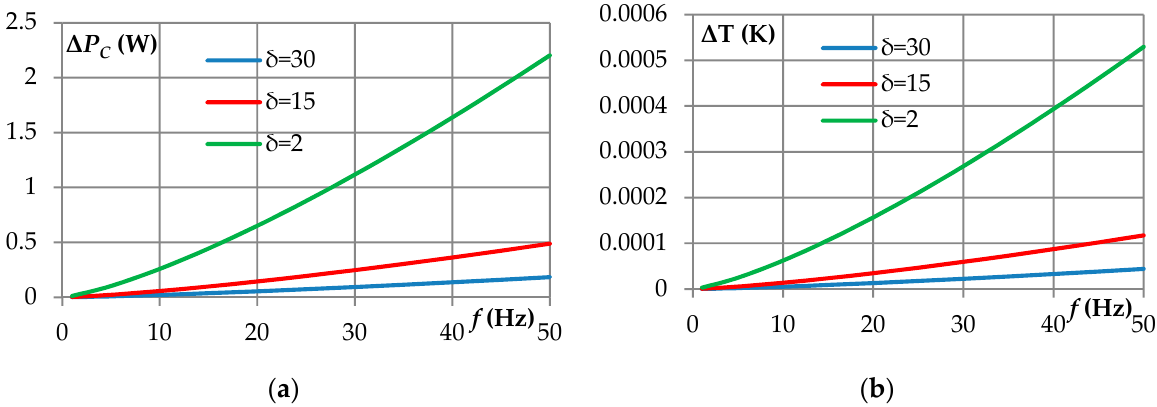
Figure 8. Core loss ( a ) and core temperature increase ( b ) as a functions of frequency.